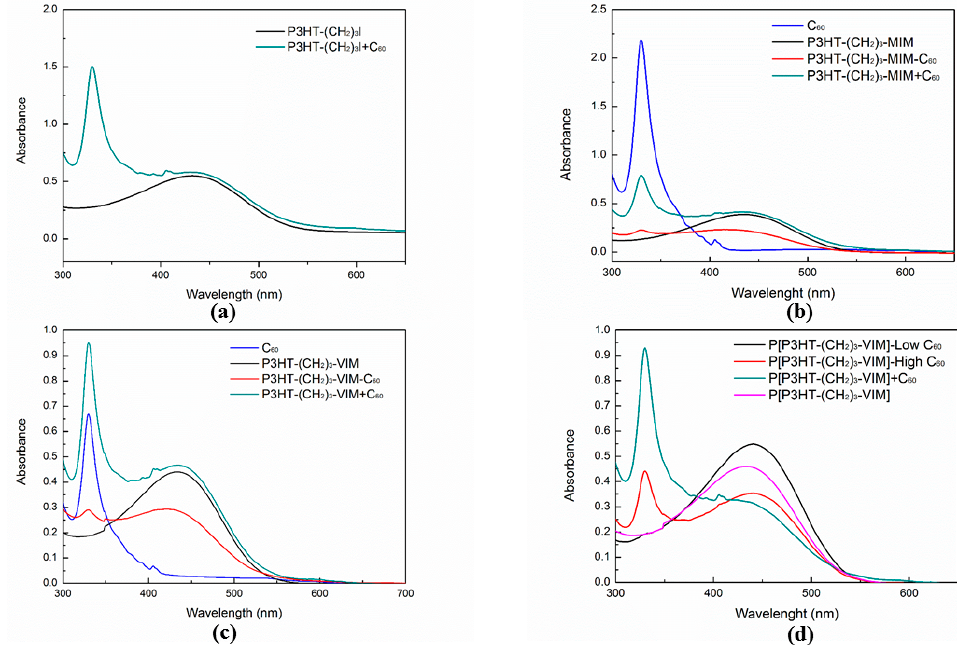
Figure 12. UV-Vis absorption spectra (all in CHCl 3 , 9.4 × 10 − 7 M) of P3HT-(CH 2 ) 3 -I and control P3HT-(CH 2 ) 3 -I + C 60 ( a ); P3HT-(CH 2 ) 3 -MIM, P3HT-(CH 2 ) 3 -MIM-C 60 , and controls C 60 and P3HT-(CH 2 ) 3 -MIM + C 60 ( b ); P3HT-(CH 2 ) 3 -VIM, P3HT-(CH 2 ) 3 -VIM-C 60 , and controls C 60 and P3HT-(CH 2 ) 3 -VIM + C 60 ( c ); P[P3HT-(CH 2 ) 3 -VIM], P[P3HT-(CH 2 ) 3 -VIM-C 60 -low], P[P3HT-(CH 2 ) 3 -VIM-C 60 -high], and control P[P3HT-(CH 2 ) 3 -VIM] + C 60 ( d ).